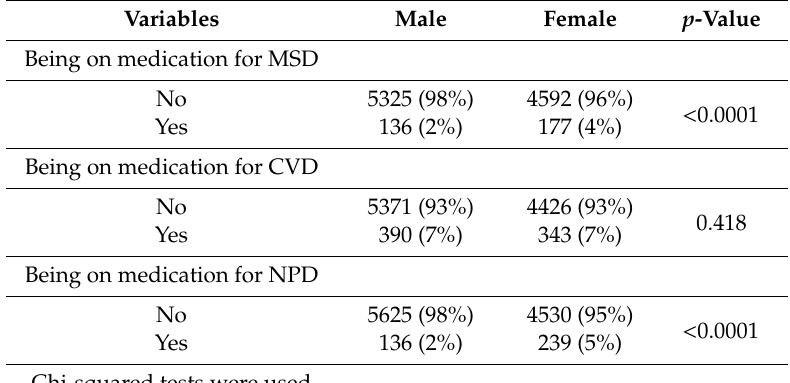
Table 2. Baseline characteristics medication use of 10530 Belgian workers by gender.